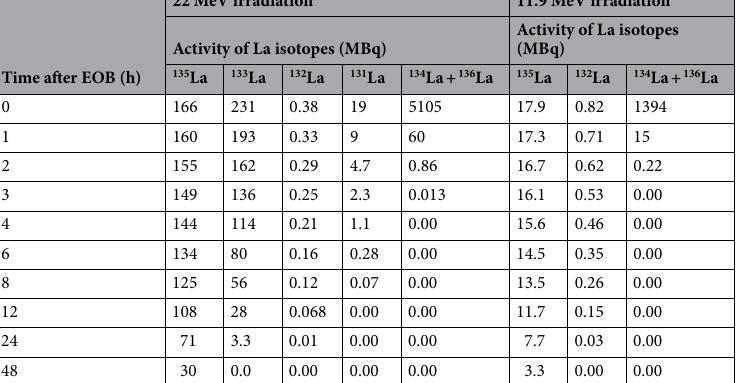
Time after EOB (h)